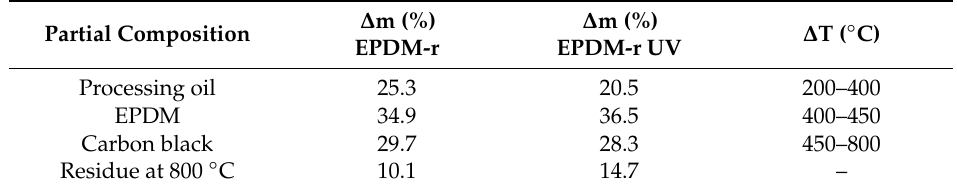
Table 2. Partial composition of the EPDM-r and the EPDM-r UV determined by the thermogravimetric analysis